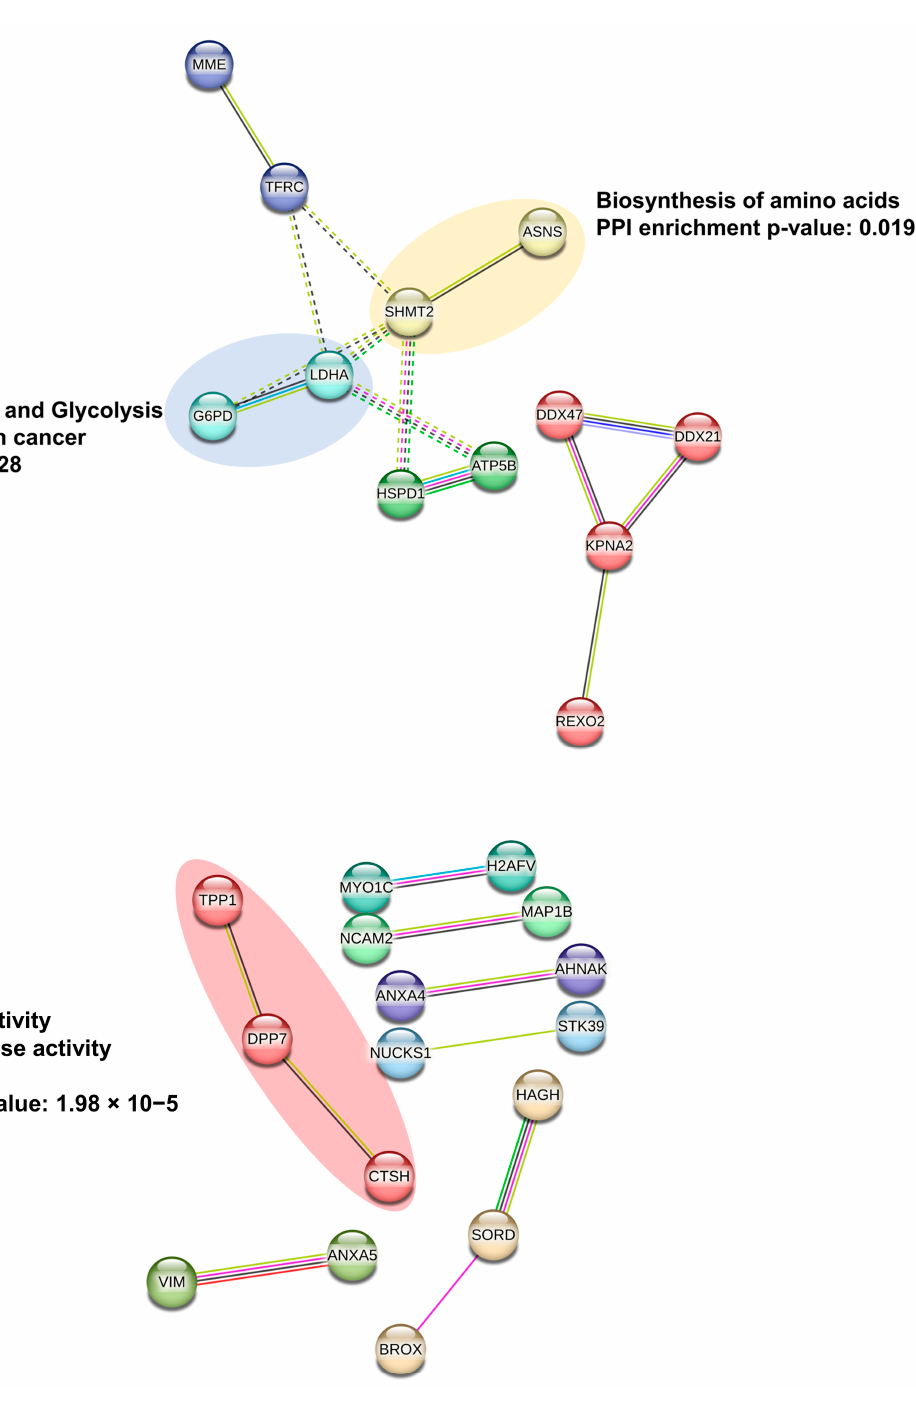
Figure 3. STRING analysis of proteomics data. Protein–protein interaction (PPI) networks of significant downregulated ( A ) and upregulated ( B ) proteins in LNCaP PCa cells expressing miR-423-5p mimic compared to control (empty vector). Analysis was performed with the search tool for retrieval of interacting genes/proteins database (STRING, version V11.0, [17]). Available online: http://stringdb.org, (accessed on 19 October 2022). Medium confidence was applied for the analysis and the Markov Cluster Algorithm (MCA) performed to extract clusters of densely connected nodes from biological networks.